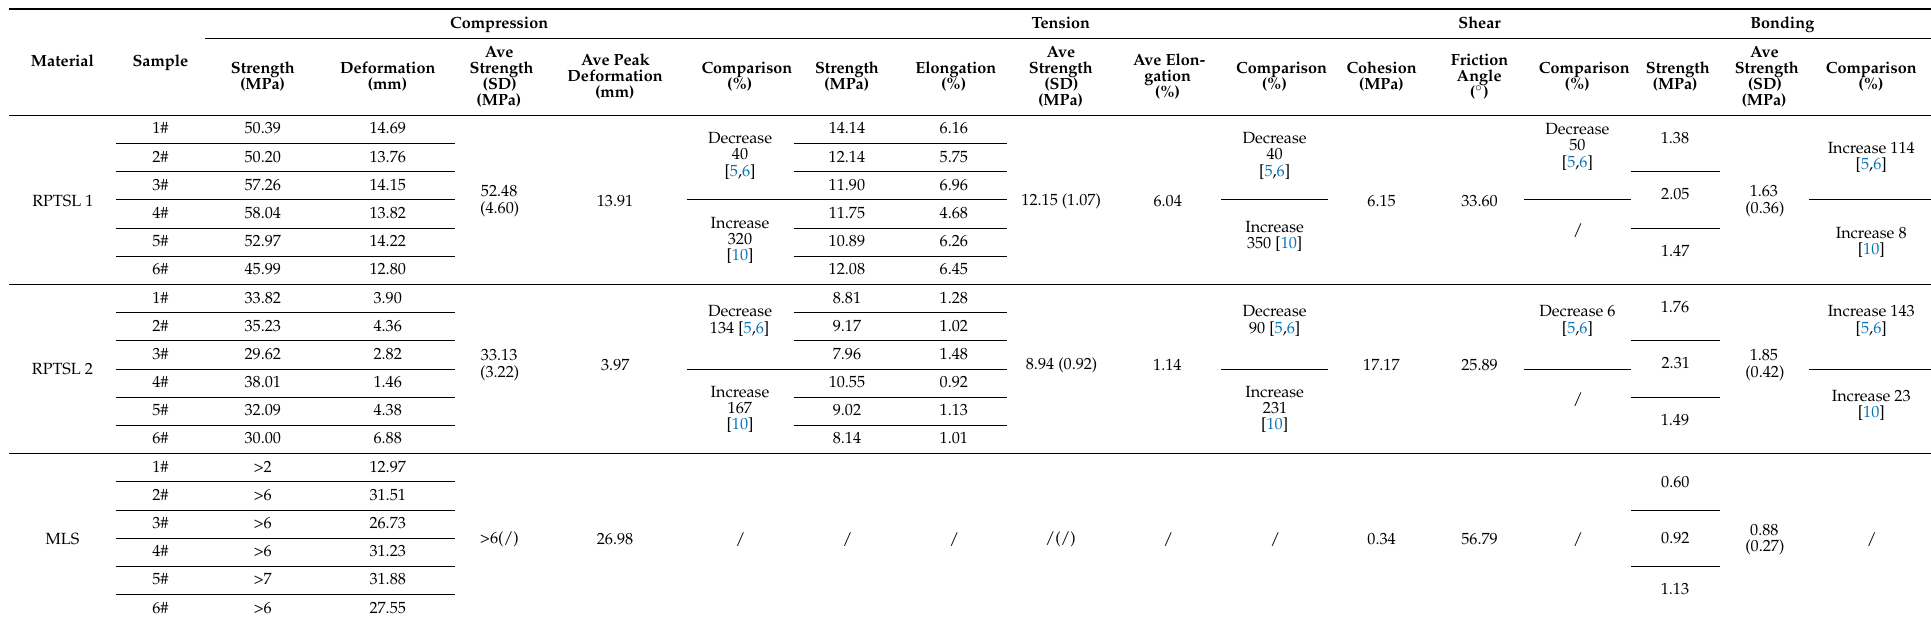
Table 2. Summary of experimental